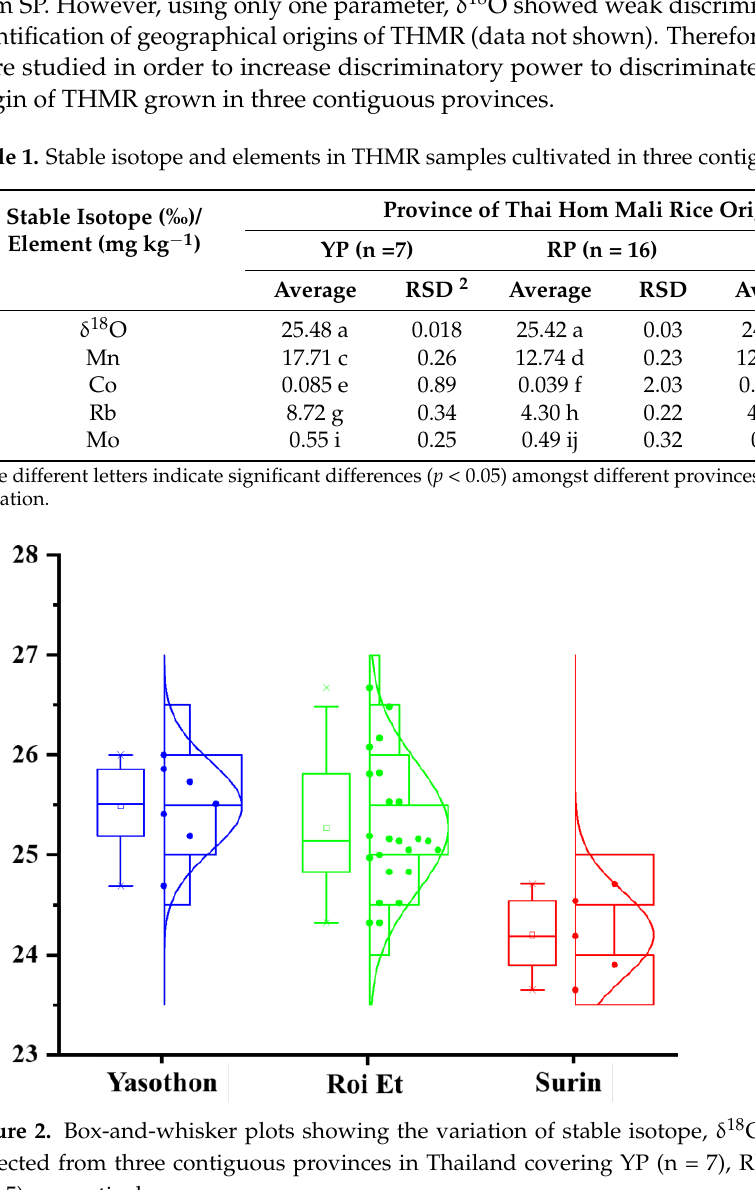
Table 1. Stable isotope and elements in THMR samples cultivated in three contiguous provinces. Stable Isotope (‰)/